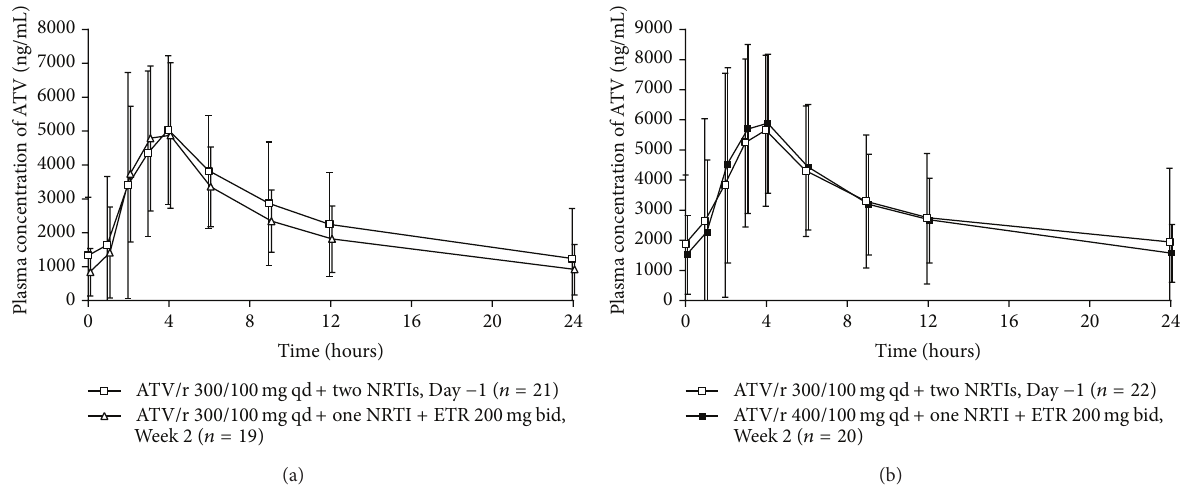
Figure3:Mean ± standarddeviationatazanavirplasmaconcentration-timecurvesafteradministrationofatazanavir/ritonavir300/100 mg qd for two weeks in combination with two NRTIs (Day − 1), followed by administration of etravirine 200 mgbid for two weeks in combination with one NRTI and (a) atazanavir/ritonavir 300/100 mgqd or (b) atazanavir/ritonavir 400/100mg qd (Week 2). ATV/r: